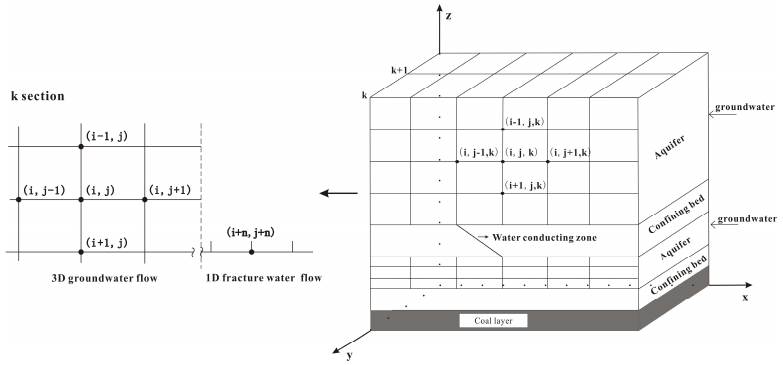
Figure 4. Schematic diagram of calculation nodes of the groundwater flow model.